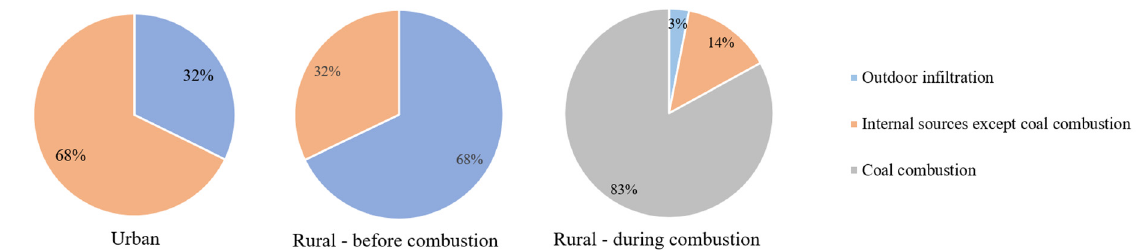
Figure 3. Contributions of outdoor infiltration, coal combustion, and other internal sources to the overall indoor UFPs with or without coal combustion.